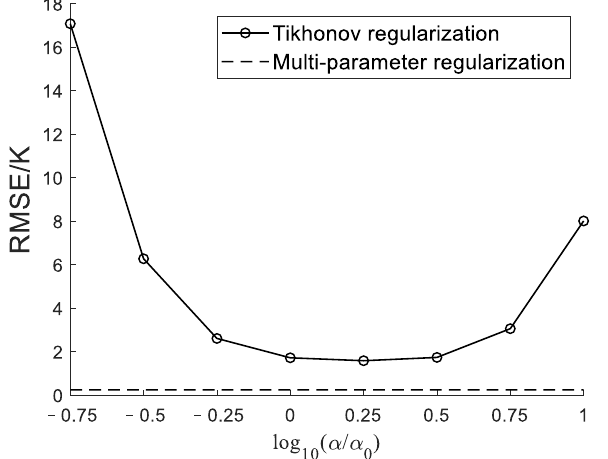
Figure 4. The performance comparison between the multi-parameter regularization and the Tikhonov regularization with different parameters.